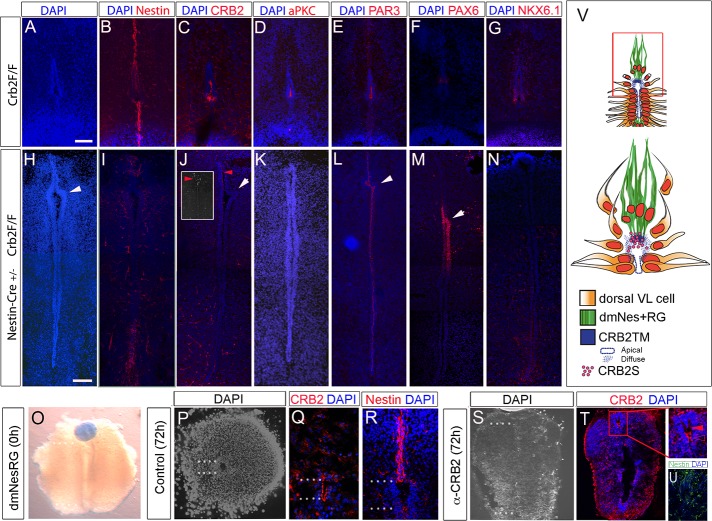
CRB2TM and CRB2S are required for dorsal collapse.(A-N) Transverse serial adjacent sections through E17 spinal cord in CRB2F/F control embryos (A-G) or CRB2F/F/Nestin-Cre+/− embryos (H-N) after immunolabelling. Knockout of CRB2TM prevents collapse; a long lumen is detected, with unusual kinks (white arrowheads). Analysis of CRB2F/F/Nestin-Cre+/− with α-CRB2 Ab (J) reveals that little/no CRB2 is detected at the apical surface of VL cells, but punctate labelling is still detected dorsally. Inset shows a section from a second embryo, showing punctate labelling in dmNes+RG. (O-U) Whole-mount view (O) or serial adjacent sections (P-U) through spinal cord slices, cultured with PBS- or α-CRB2 Ab–soaked bead. White dots indicate length of lumen. In (T) CRB2 is detected at the apical surface of VL cells, including those at the dorsal pole, but no diffuse labelling is detected in dmNes+RG (arrowhead in boxed region). The view shown in (U) is that of the boxed region in (T). (V) Schematic shows model: CRB2S is secreted from the endfeet of dmNes+RG and binds to adjacent apical cells, resulting in their down-regulation of apical/junctional proteins, altered polarity, delamination, and migration along dmNes+RG scaffold. Scale bars: 50 μm. Ab, antibody; aPKC, atypical protein kinase C; CRB2S, secreted CRB2; CRB2TM, transmembrane CRB2; dmNes+RG, dorsal midline Nestin(+) radial glia; PAR3, polarity protein PAR3; Pax6, paired-box 6; VL, ventricular layer.